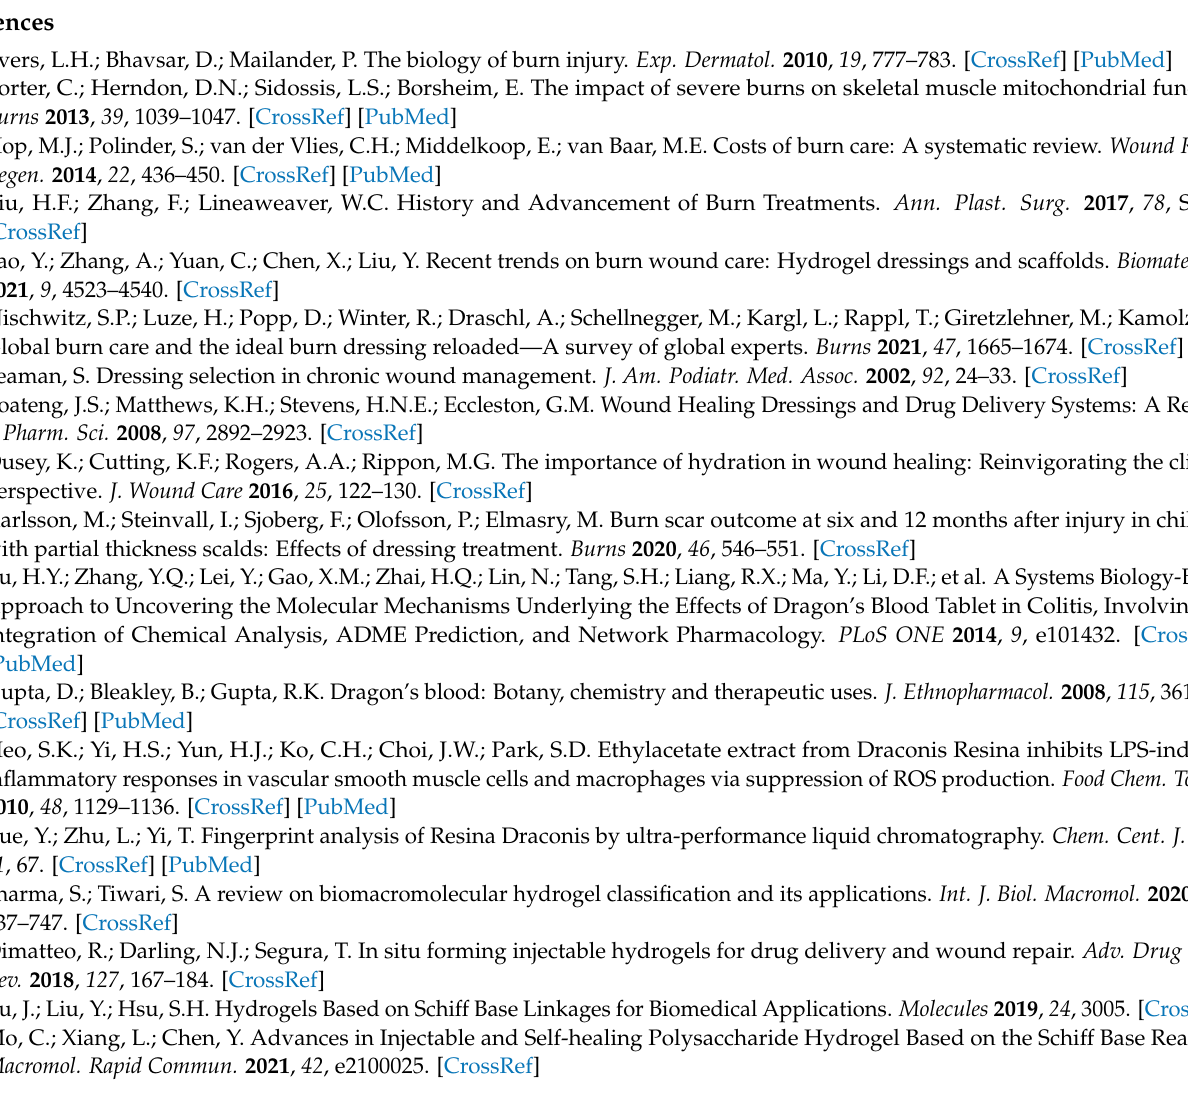
A. Figure S2: Standard Curve of Loureirin B. Figure S3: Release of LoureirinA and Loureirin B from the Resina Draconis particles in vitro. Figure S4: FT-IR spectra of (a) HA, (b) OHA. Figure S5: G (cid:48)